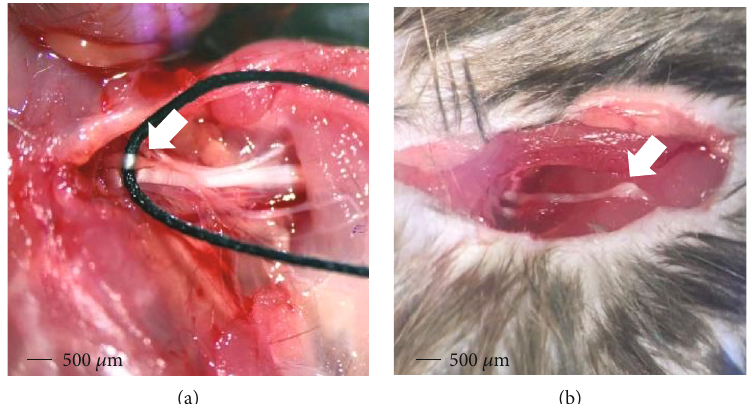
Figure 1: Surgical procedure of the novel C7 single root avulsion mouse model through an anterior approach: (a) a soft silk thread was used to hook the C7 nerve root for the preparation of avulsion injury (white arrow); (b) the avulsed C7 nerve root where the DRG of this root could be observed (white